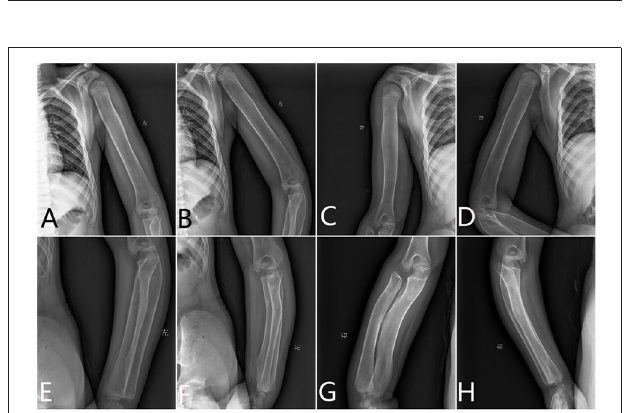
Hand. The modeling abnormality of the tubular bones was greatest in the proximal and middle phalanges, which looks like a bullet shape. These bones were widest in the midportion of the diaphyses. A similar but less marked modeling abnormality was present in the metacarpals, but not in the distal phalanges. There is osteopenia and absence of the normal thick diaphyseal cortex, which makes all tubular bones of cortical thin. The epiphyses and carpal bones were smaller than the normal standards ( Figure 3 ). However, the tip of each finger showed sharply pointed distal phalanges without changes after growth. The ossification centers of those carpal bones were quite small. Lower